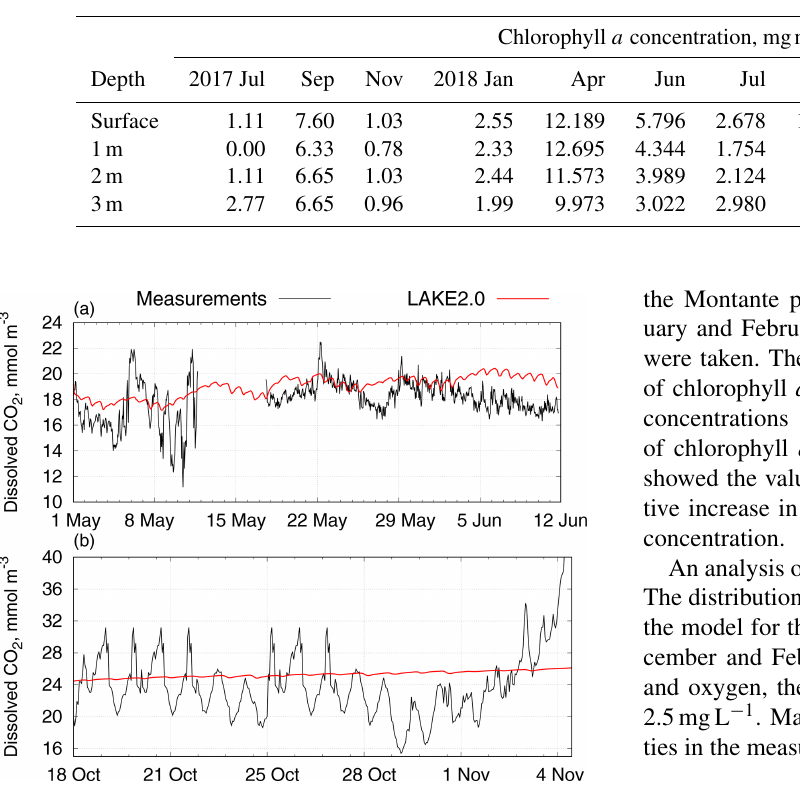
Figure 8. Time series of dissolved CO 2 in water at 25cm